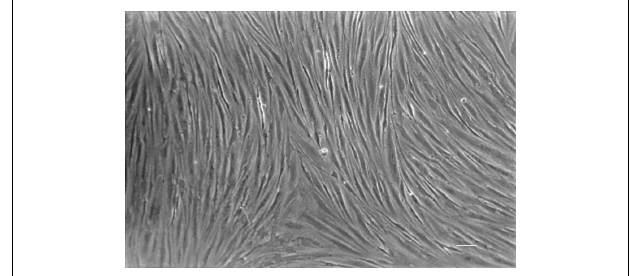
FIGURE 1 | Phase contrast image of a representative confluent monolayer of human brain endothelial culture at 30days in vitro